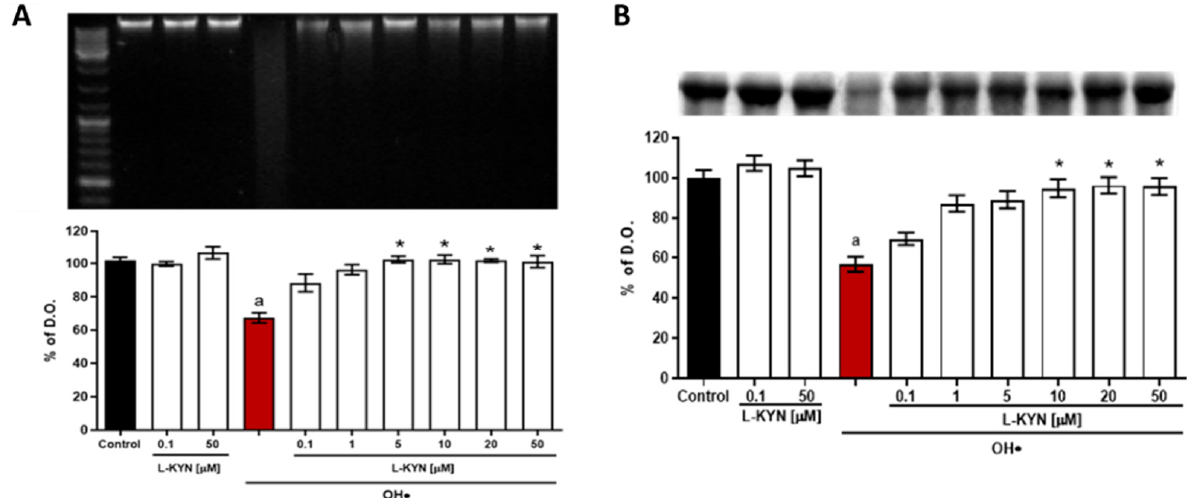
Figure 4. Protective effect of L-KYN on DNA and BSA oxidative degradation induced by • OH. ( A ) Representative blot for stained-DNA detection (upper panel): line 1, molecular weight marker; line 2, DNA; line 3, DNA + L-KYN (0.1 µ M); line 4, DNA + L-KYN (50 µ M); line 5 DNA + • OH; lines 6–11, DNA + • OH + L-KYN (0.1, 1, 5, 10, 20, 50 µ M, respectively) and quantitative representation for DNA detection (lower panel). ( B ) Representative Coomassie blue-stained-BSA gel (upper panel): line 1, BSA; line 2, BSA + L-KYN (0.1 µ M); line 3, BSA + L-KYN (50 µ M); line 4 BSA + • OH; lines 5–10, BSA + ● OH + L-KYN (0.1, 1, 5, 10, 20, 50 µM, respectively) and quantitative representation for BSA detection (lower panel). Data are presented as mean ± S.E.M. of 3 independent experiments. a p < 0.05 • OH vs. control; * p < 0.05 L-KYN with a specific concentration vs. • OH, based on the Kruskal–Wallis test, with Dunn’s test for multiple pairwise comparisons. Table 2. The effect of L-KYN on • OH-induced the DNA and Protein (BSA) oxidation. Medians of percentages of DNA and Protein oxidation and p -values associated with the effect of increasing concentrations of L-KYN vs. • OH, using Dunn’s test for multiple pairwise comparisons.